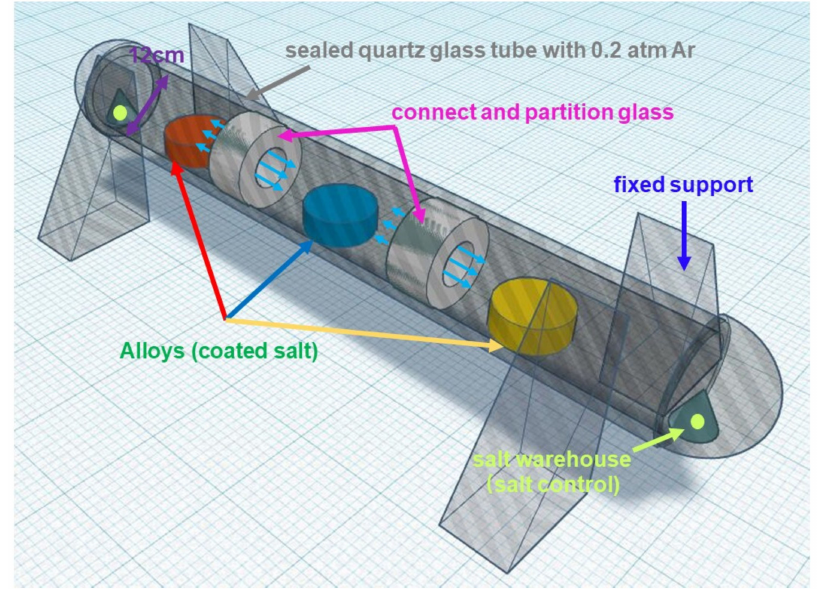
Figure 2. The design of tube sealing experiment.